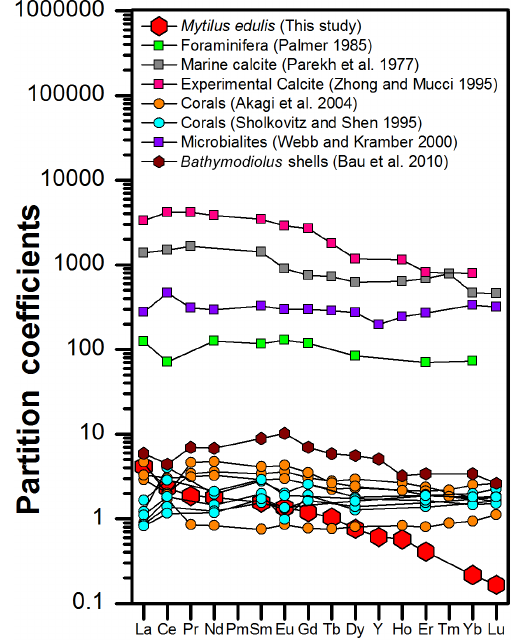
Figure 7. REY partition coefficients for different marine carbonates and ambient seawater (field studies and laboratory